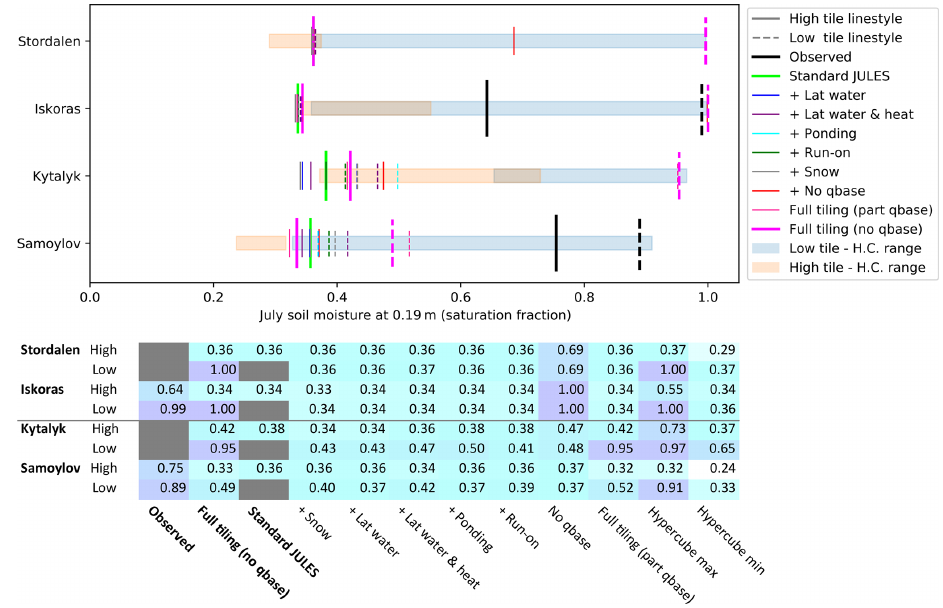
Figure B1. Average July soil moisture (2000–2016) at 0.19m for the additive process-switching runs, where model processes are switched on one at a time starting from the base configuration of standard JULES (light green). The depths of the observations are as follows: for Samoylov, the rim was at 0.22m and the centre was at 0.23m, and for Iškoras the palsa and mire were both at 0.2m.